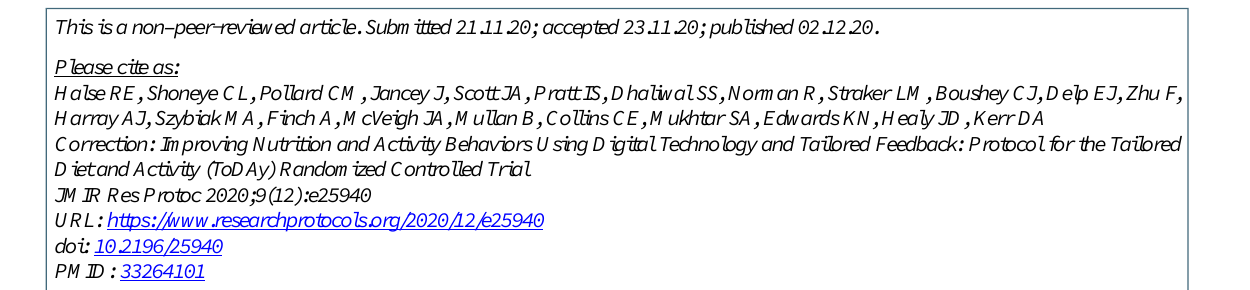
Table 1. Frequency of assessment of variables in the LiveLighter ToDAy study for the tailored feedback, active control, and online control